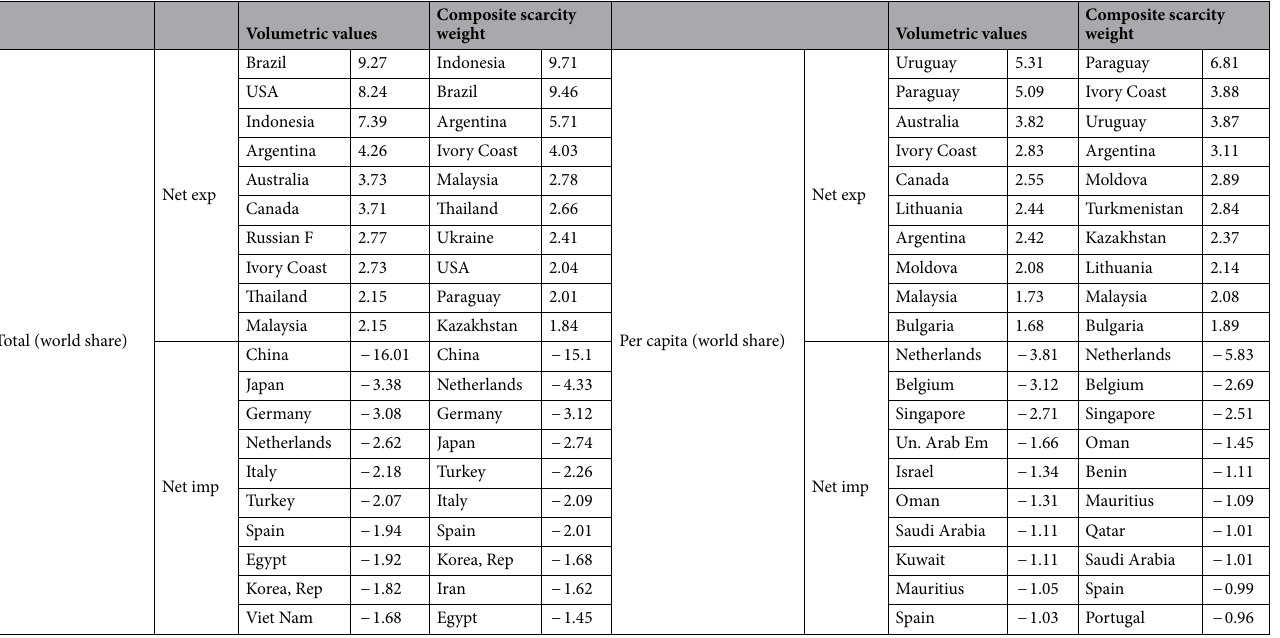
Table 1. Top 10 countries for net VW export and import, in volumetric values and weighted for the composite water scarcity index. The left layer is referred to absolute figures ( SN and SWN , in percentage of the world total). The right layer is referred to per capita figures ( sn and swn , in percentage of the world